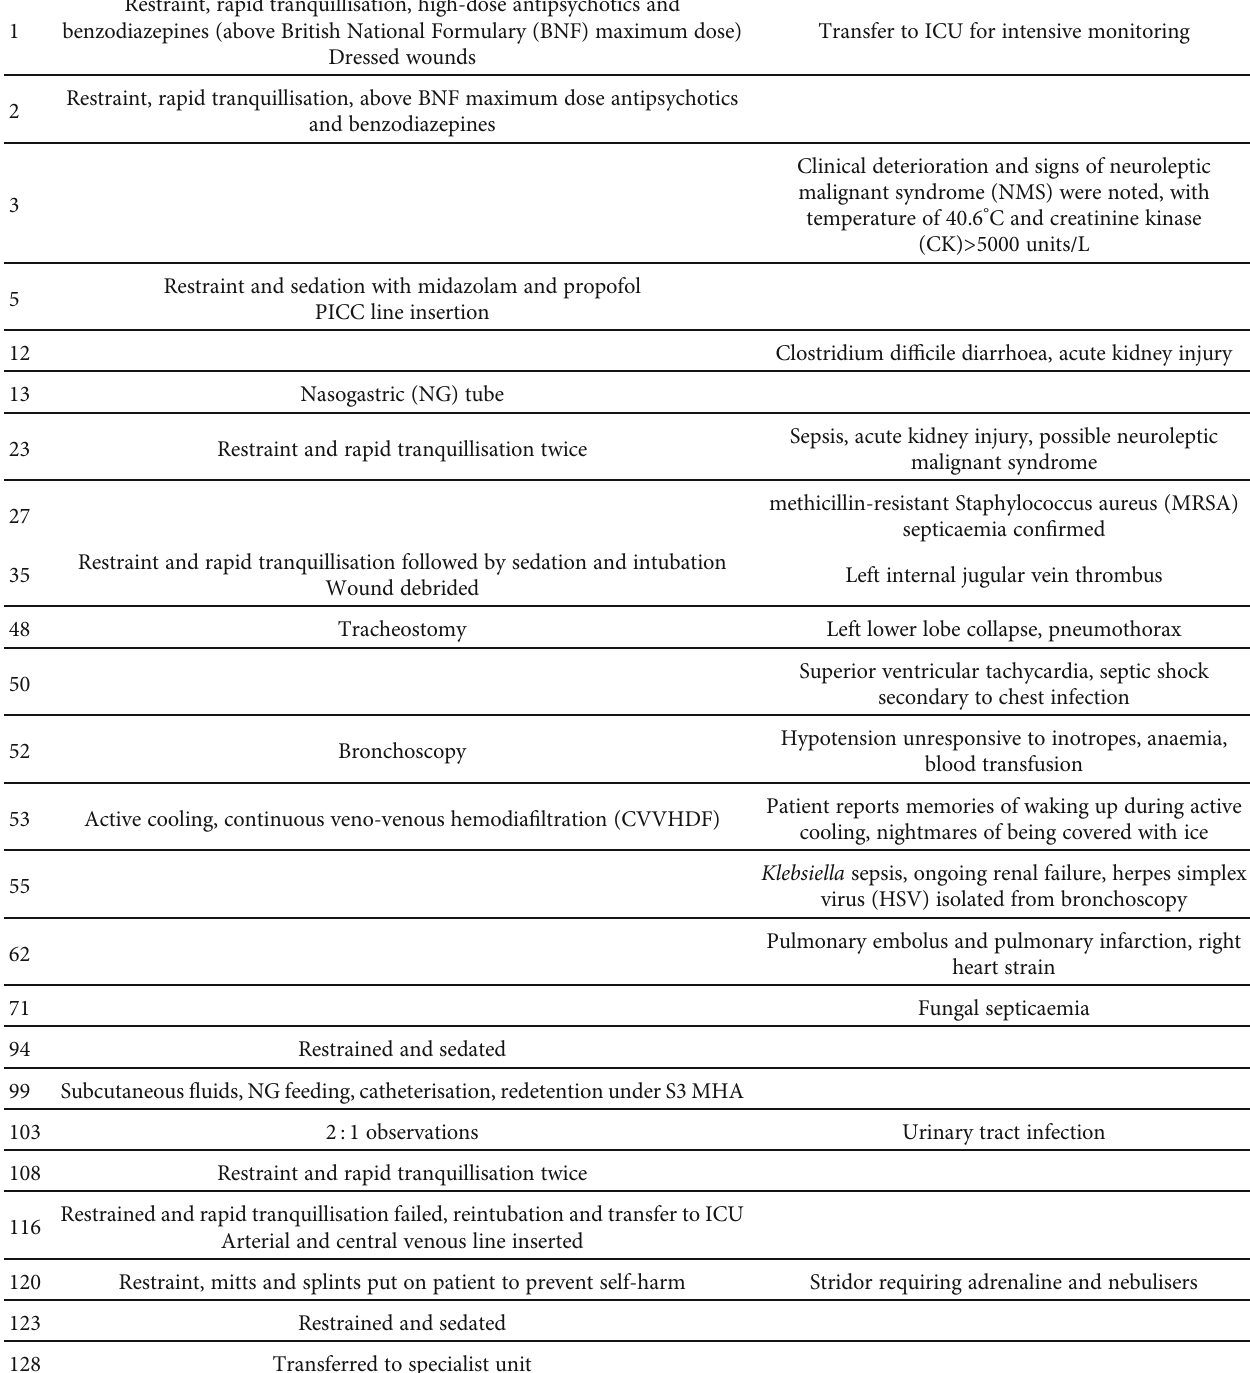
Table 1: Summary of interventions and complications during the acute hospital admission. There were at least 17 episodes of physical restraint, with nine requiring rapid tranquillisation and four requiring intubation and admission to ICU. Day Intervention and treatment Complications or unintended consequences Restraint, rapid tranquillisation, high-dose antipsychotics and 1 benzodiazepines (above British National Formulary (BNF) maximum dose) Transfer to ICU for intensive monitoring Dressed wounds Restraint, rapid tranquillisation, above BNF maximum dose antipsychotics 2 and benzodiazepines Clinical deterioration and signs of neuroleptic malignant syndrome (NMS) were noted, with temperature of 40.6 ° C and creatinine